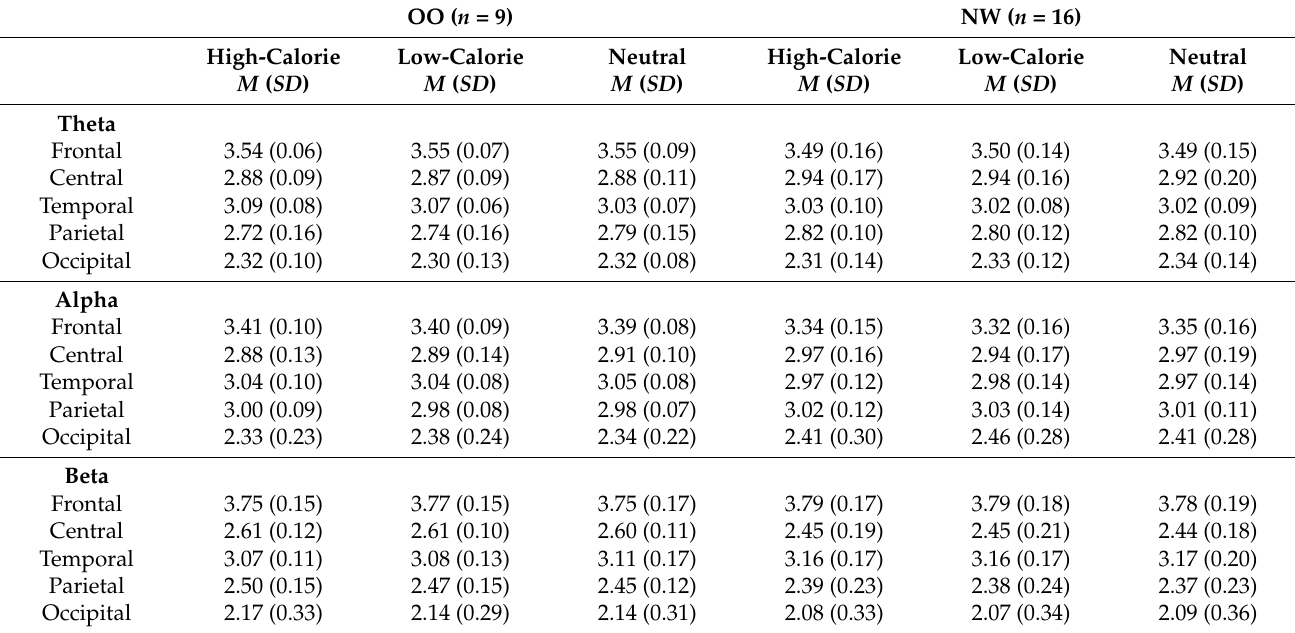
Table 2. Descriptive data on frequency band analyses of stimulus-elicited electroencephalography activity as a function of weight